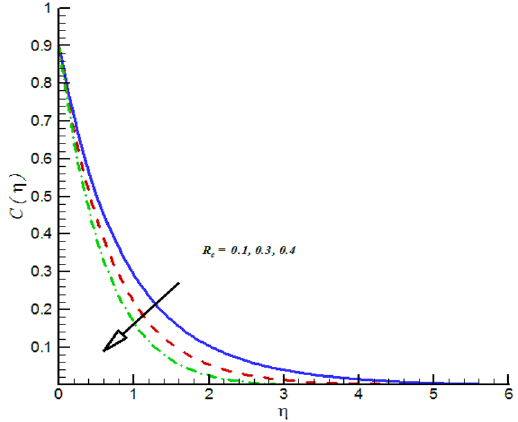
Figure 20. Impact of R c on C ( η ).